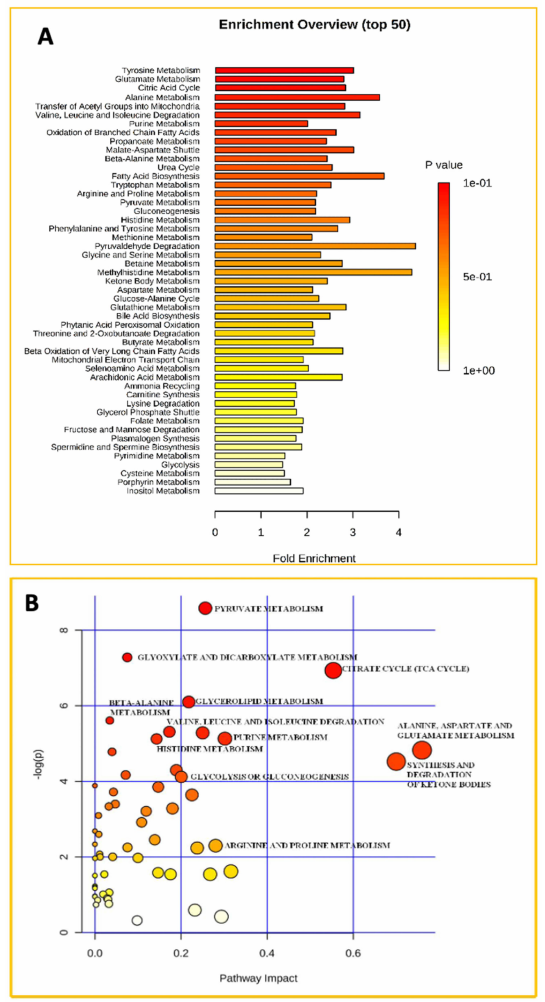
Figure 1. Panel ( A ) Metabolic set enrichment analysis showing the most altered metabolisms as revealed in the plasma of hypogonadal men before and after testosterone replacement treatment (TRT). Color intensity (white to red) reflects increasing statistical significance, while the circle diameter covaries with pathway impact. The graph was obtained by plotting − log of p -values from pathway enrichment analysis on the y -axis and the pathway impact values derived from pathway topology analysis on the x -axis. Panel ( B ) Metabolic Pathway Analysis (MetPA). All the matched pathways are displayed as circles. The color and size of each circle is based on the p -value and pathway impact value, respectively. The graph was obtained by plotting on the y -axis the − log of p values from the pathway enrichment analysis and on the x -axis the pathway impact values derived from the pathway topology